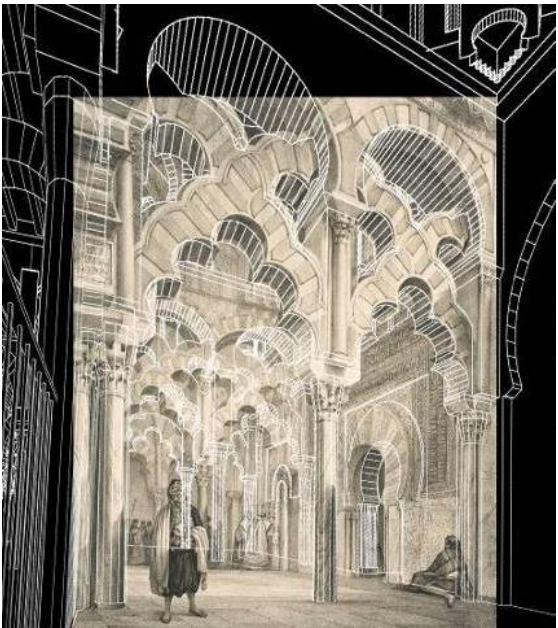
Figure 23. Girault de Prangey (1839). Digital model overlapping the mihrab side. Source: Own production.